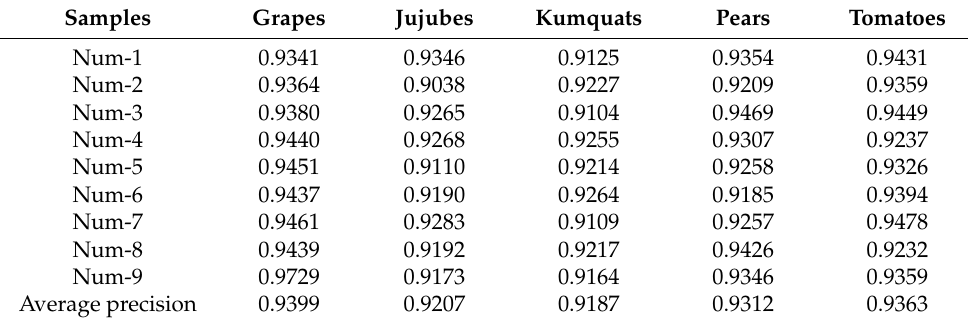
Table 5. Testing five samples with our proposed CNN.